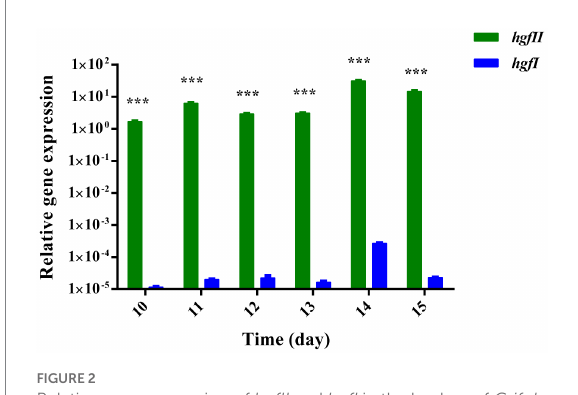
FIGURE 2 Relative gene expression of hgfII and hgfI in the hyphae of Grifola frondosa cultivated in liquid medium. Statistically significant difference: *** p ≤ 0.001 (Multiple t-